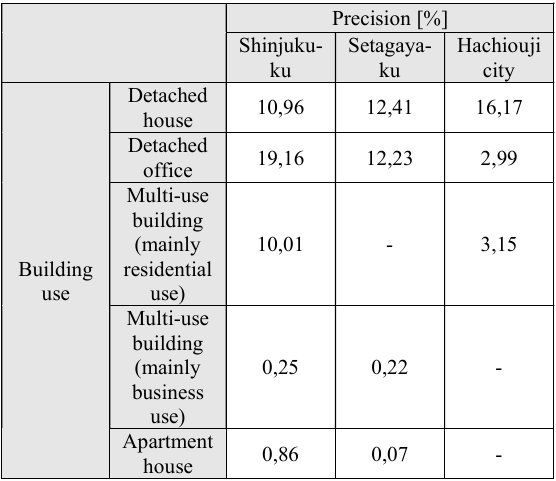
Table 3. Precision per building